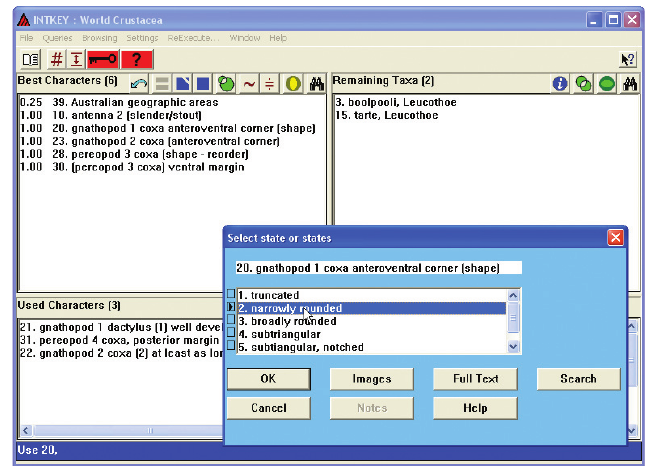
Figure 79. Character 20 is dependent on character 18. After selecting the character state ‘ produced ’ in character 18, the character state dialog box appears for a selection of a character state of character